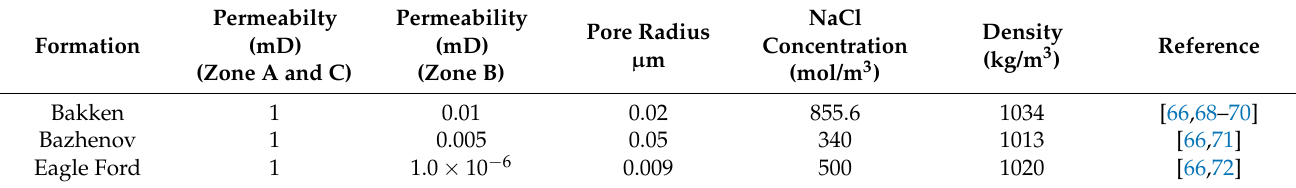
Table 4. Parameters of the numerical